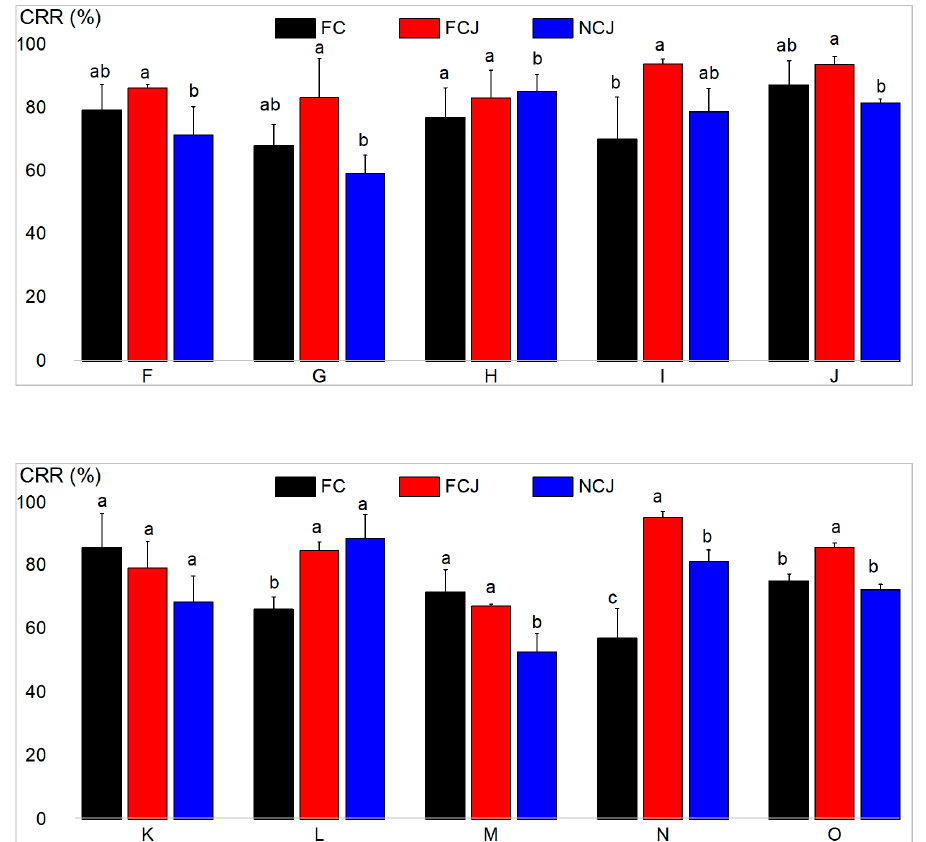
Figure 3. CRR of fresh citrus (FC), fresh citrus juice (FCJ) and not-from-concentrate citrus